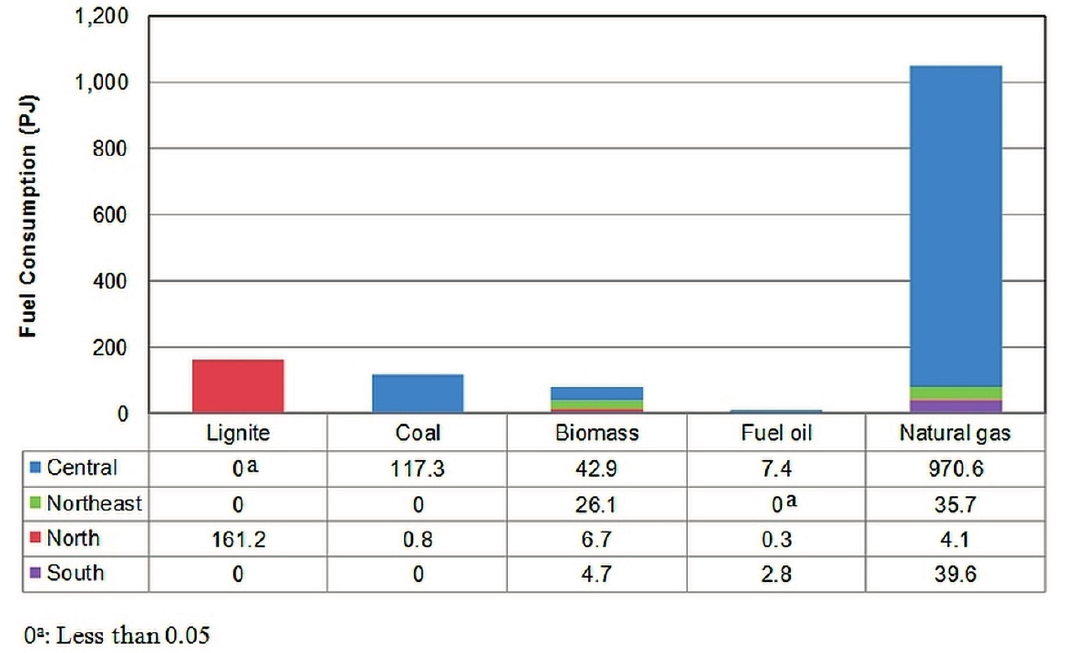
Figure 1. Fuel Consumption in Power Plants in 2010 by Region. 0 a : Less than